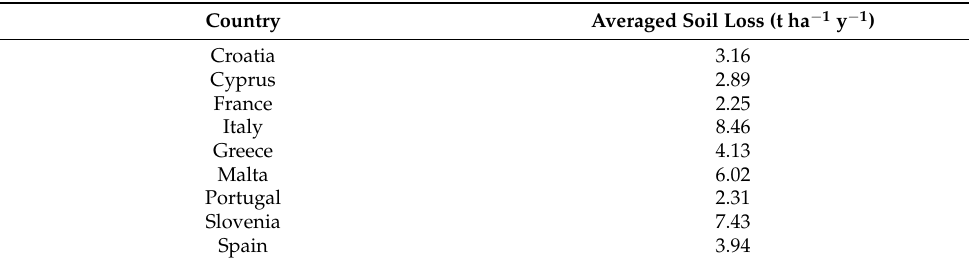
Table 3. Average soil loss rate in Mediterranean